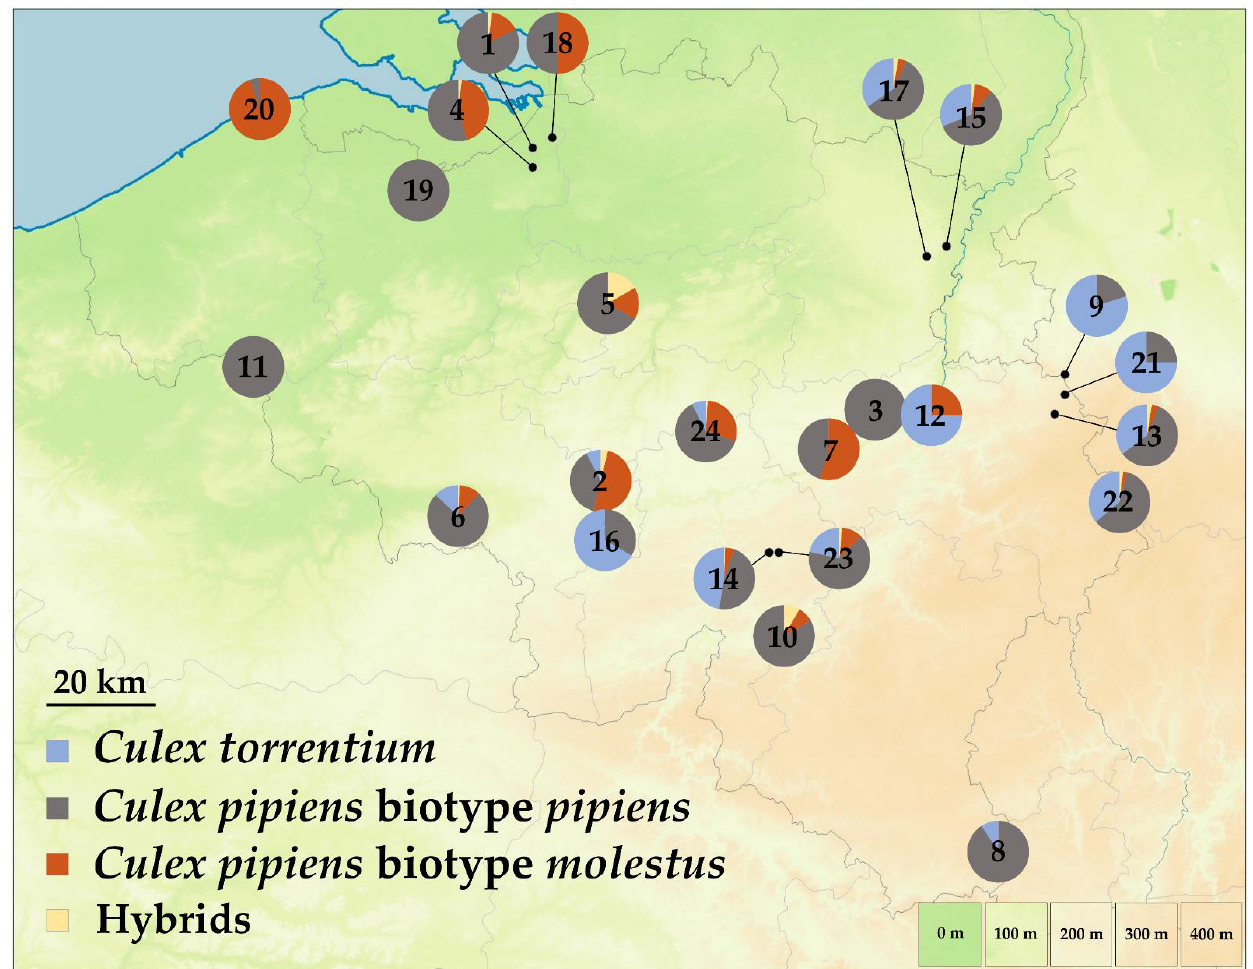
Figure 1. Distribution of Culex specimens identified using DNA-based techniques and collected during the MEMO survey 2017–2019 [11]. Hybrids = Cx. pipiens biotype pipiens X Cx. pipiens biotype molestus . The numbers indicated on the pie charts are the collection site numbers used in Table S3. The pairwise F ST values, i.e., a measure of the average genetic differentiation, between Cx. pipiens biotype pipiens and Cx. pipiens biotype molestus , were significantly different from zero, which was also the case between the latter and the hybrids (Table 1). The hybrids and Cx. pipiens biotype pipiens showed the smallest average pairwise nucleotide differences and the lowest average nucleotide diversities (Table 2), despite Cx. pipiens biotype pipiens being the most widespread taxon in this survey (Figure 1; Table S4). Culex torrentium showed higher average pairwise nucleotide differences and nucleotide diversities than Cx. pipiens biotype pipiens (Table 2).